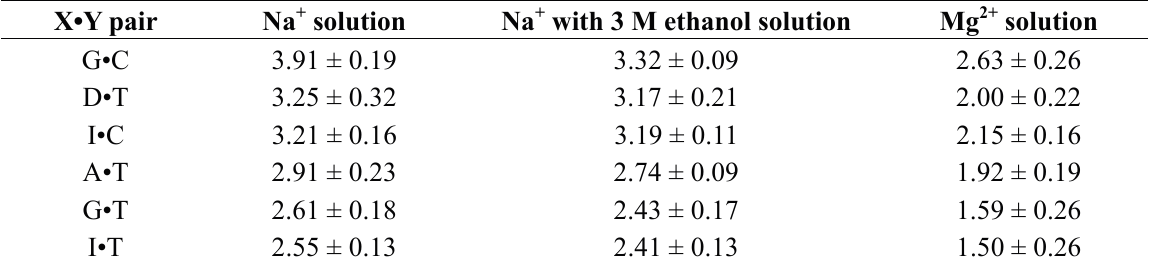
Table 1. Dependence of −∆ G ° of the duplexes on log [M] in a linear range under different solution